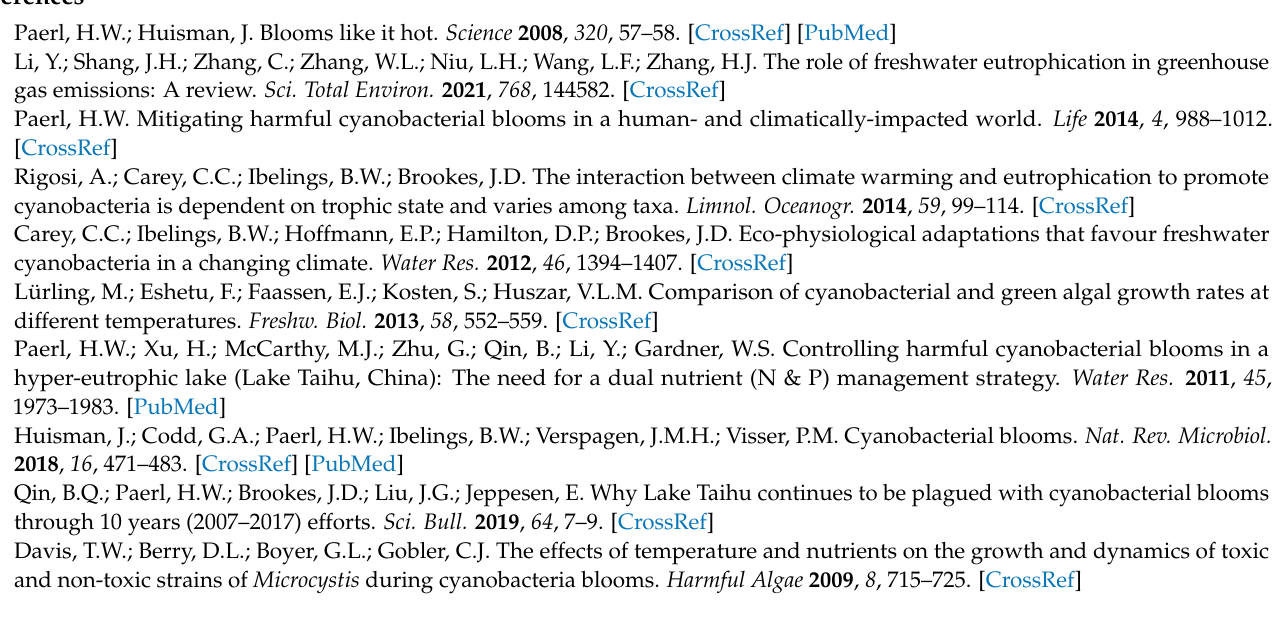
change of maximum cell density showing in parentheses. References [57,78–80] are cited in the supplementary